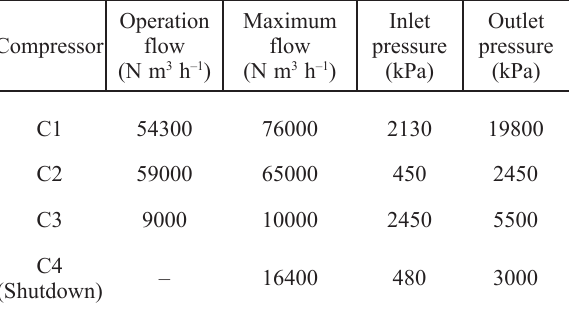
Table 2 – Compressors data for case study 27